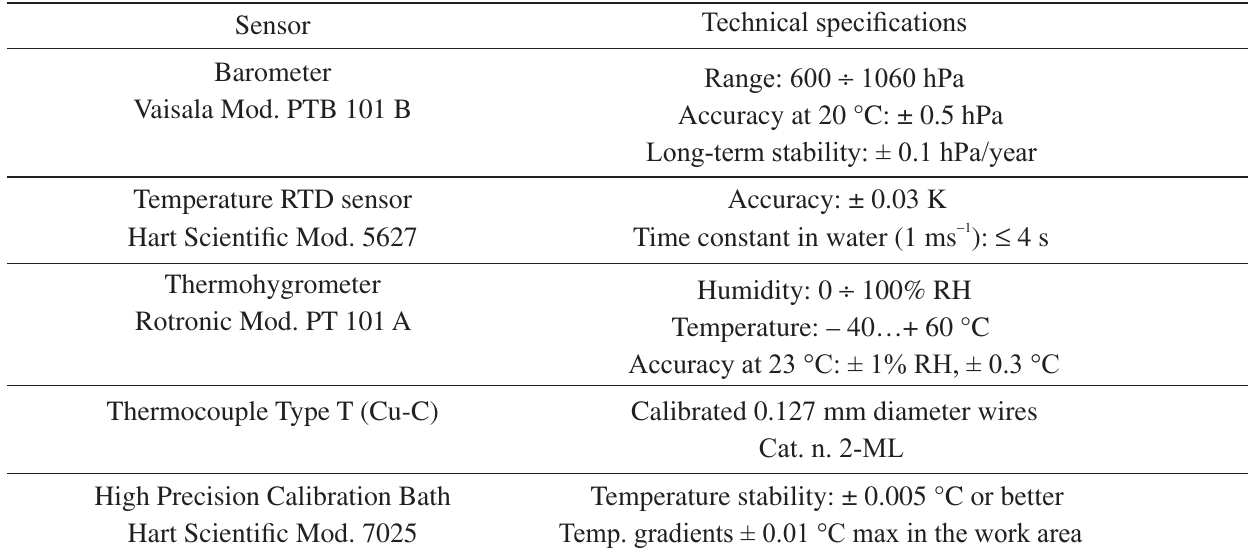
Table I. Meteorological sensors used on the airplane and calibration